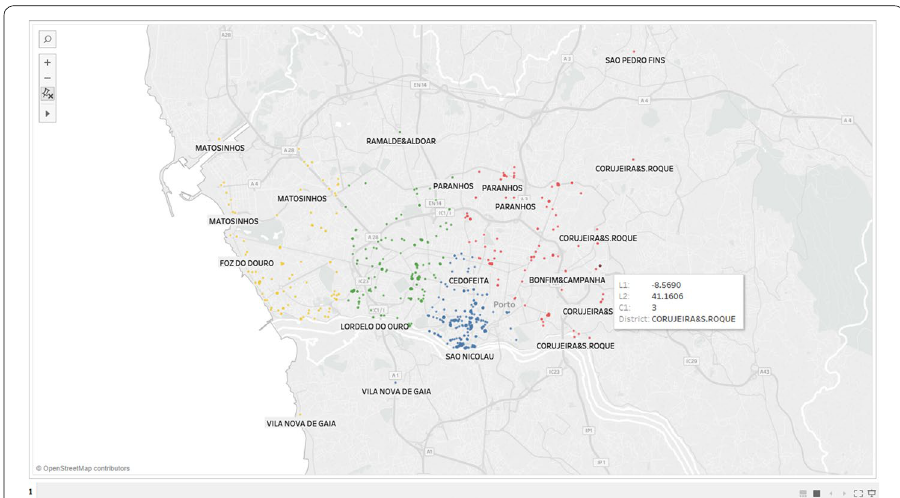
Fig. 11 Trips origin clusters on Friday at 6:00